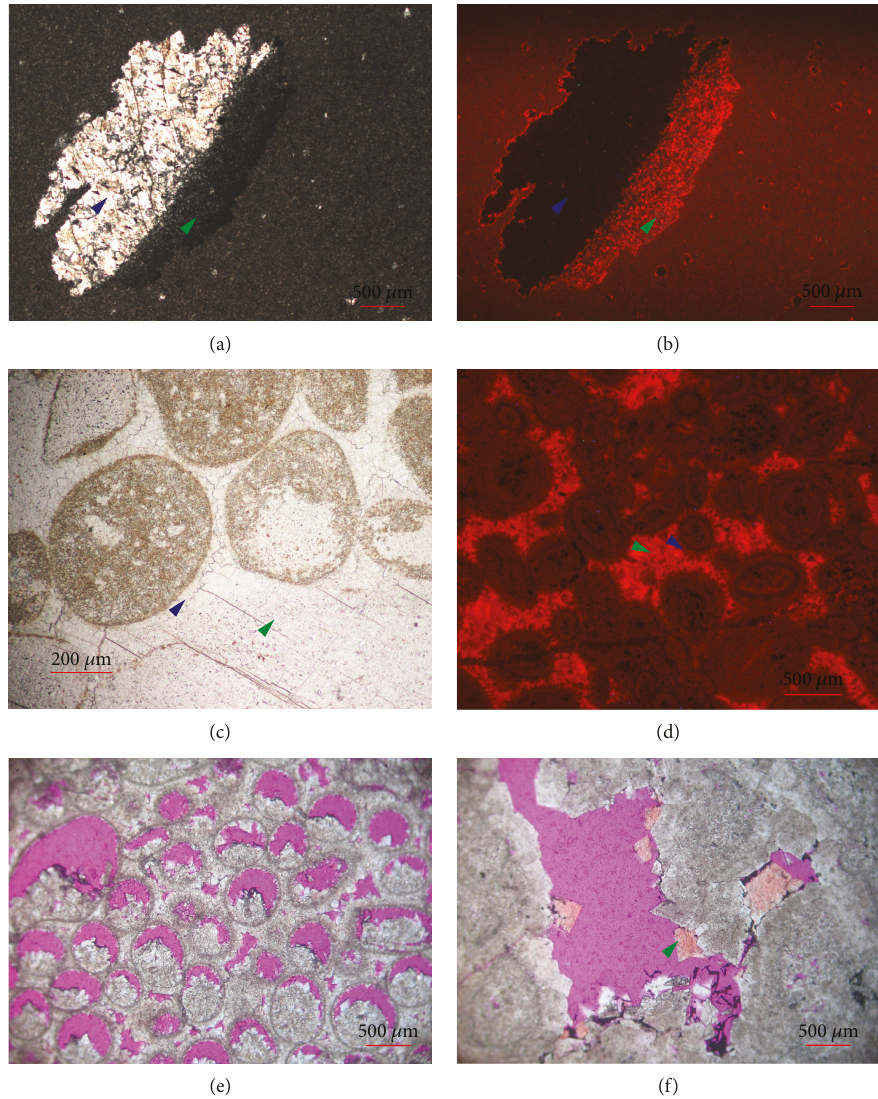
Figure 3: Microscopic characteristics of fl uid dissolution in carbonate rocks. (a) Granular calcite (blue arrow) fi lled in casting cave after gypsum dissolution in fi ne crystalline dolomite. Karst residual debris (green arrow) occurs at the bottom of the cave (O m, polarized light, 2 25x, from well Lian 5, Ordos Basin). (b) Cathodoluminescence features of picture (a). Calcite fi lled in casting cave has no cathodoluminescence (blue arrow). Karst residual debris (green arrow) has dotted red cathodoluminescence. (c) Annular radial calcite (blue arrow) formed in early-stage seawater and granular calcite formed in deep burial formation water (green arrow) fi lling intergranular pores in granular limestone (O yj, 100x, from well T708 of the Tahe oil fi eld, Tarim Basin). (d) Annular radial calcite (blue arrow) formed 2 in early seawater and granular calcite (green arrow) formed in the deep burial stage fi lling intergranular pore in oolitic limestone. They emit weak and bright red cathodoluminescence under cathode irradiation, respectively (O b, 25x, from the Qiliao outcrop in Shizhu, 2 Sichuan Basin). (e) Oolitic dolomite rich in intragranular dissolution pores (T f, at 5166m, 40x, from well PG2, Puguang gas fi eld, 1 Sichuan Basin). (f) Bladed calcite (green arrow), which is related to TSR, fi lling dissolution vug in medium-coarse crystalline dolomite (T f, 40x, from well PG2, Puguang gas fi eld, Sichuan 1